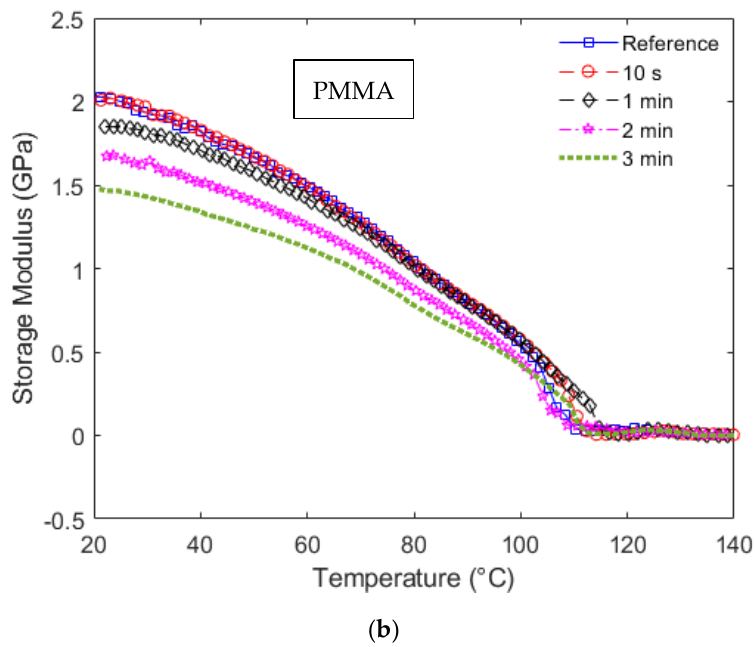
Figure 4. Storage modulus as a function of the temperature at each UV radiation condition for ( a ) CYTOP and ( b ) PMMA fiber.